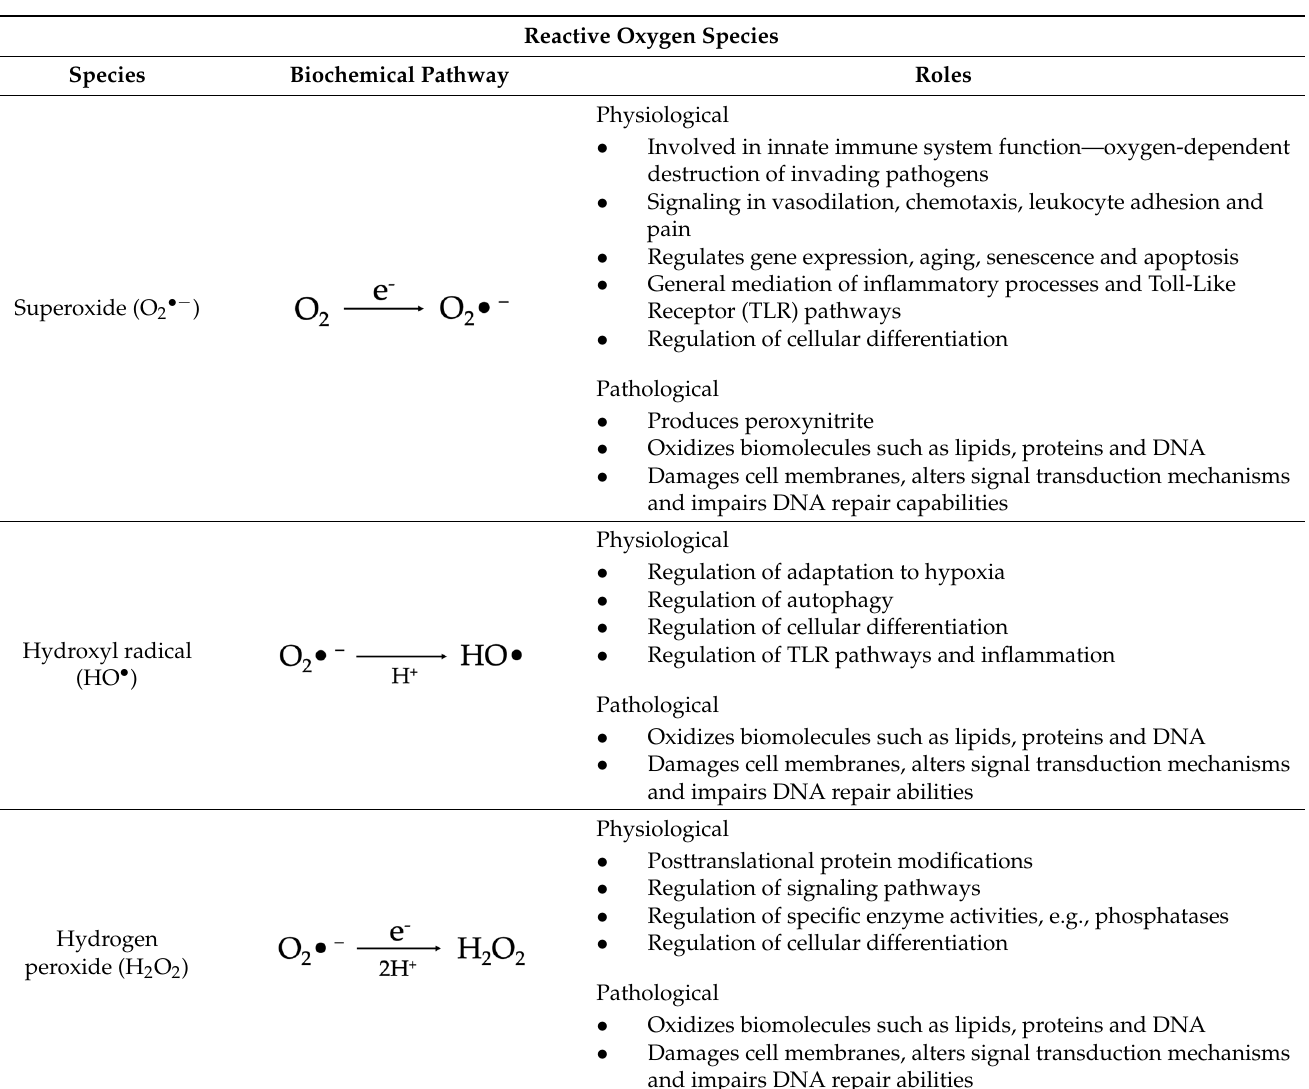
Table 1. Key reactive oxygen species, the reactions that generate them and their physiological and pathological properties.